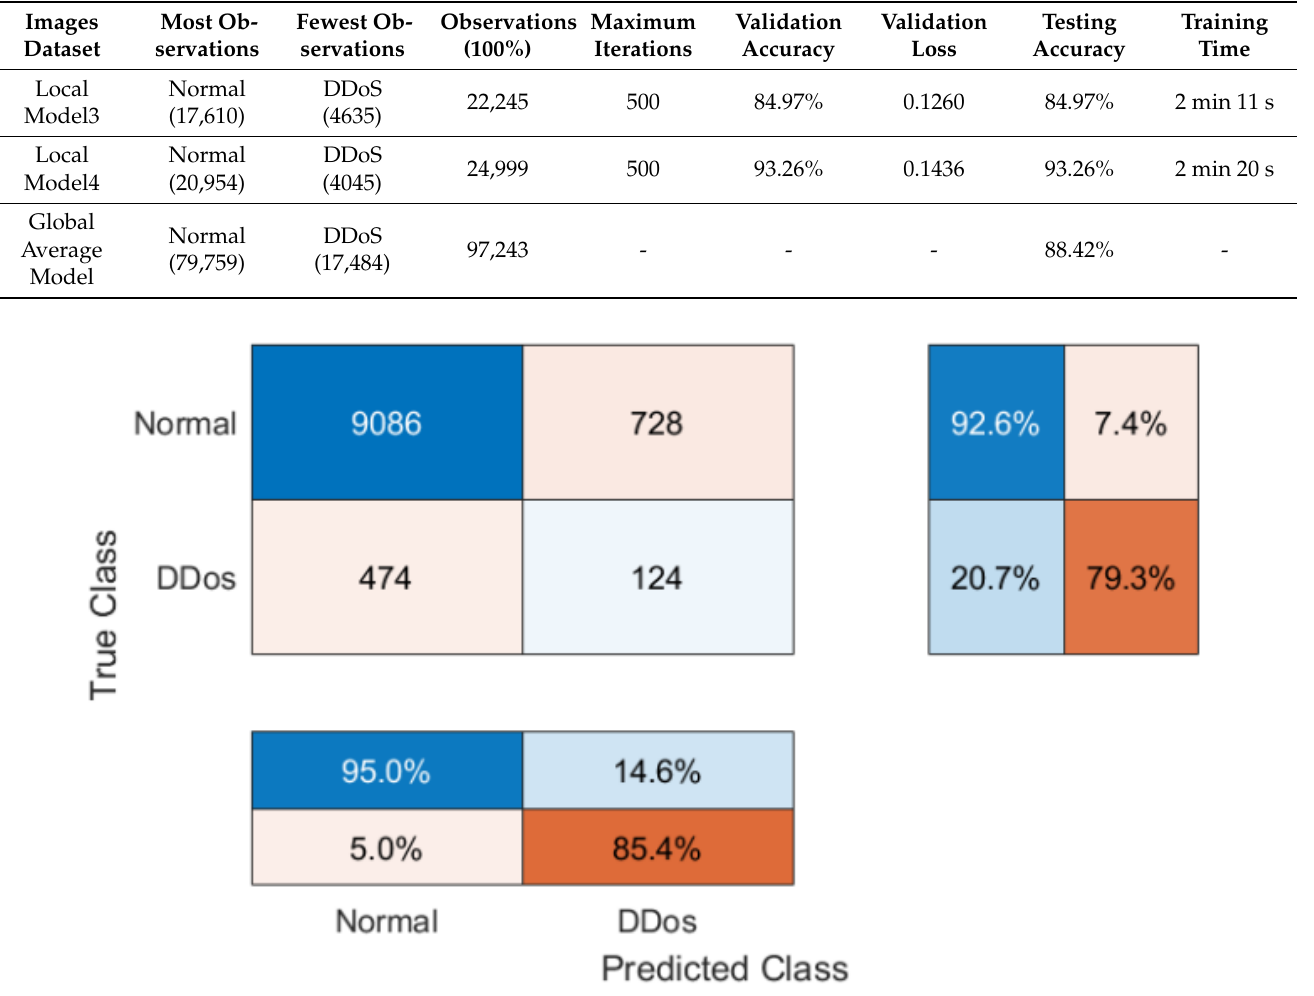
Figure 17. Training progress and performance of the FL method: ( a ) loss evaluation of Local Model4;